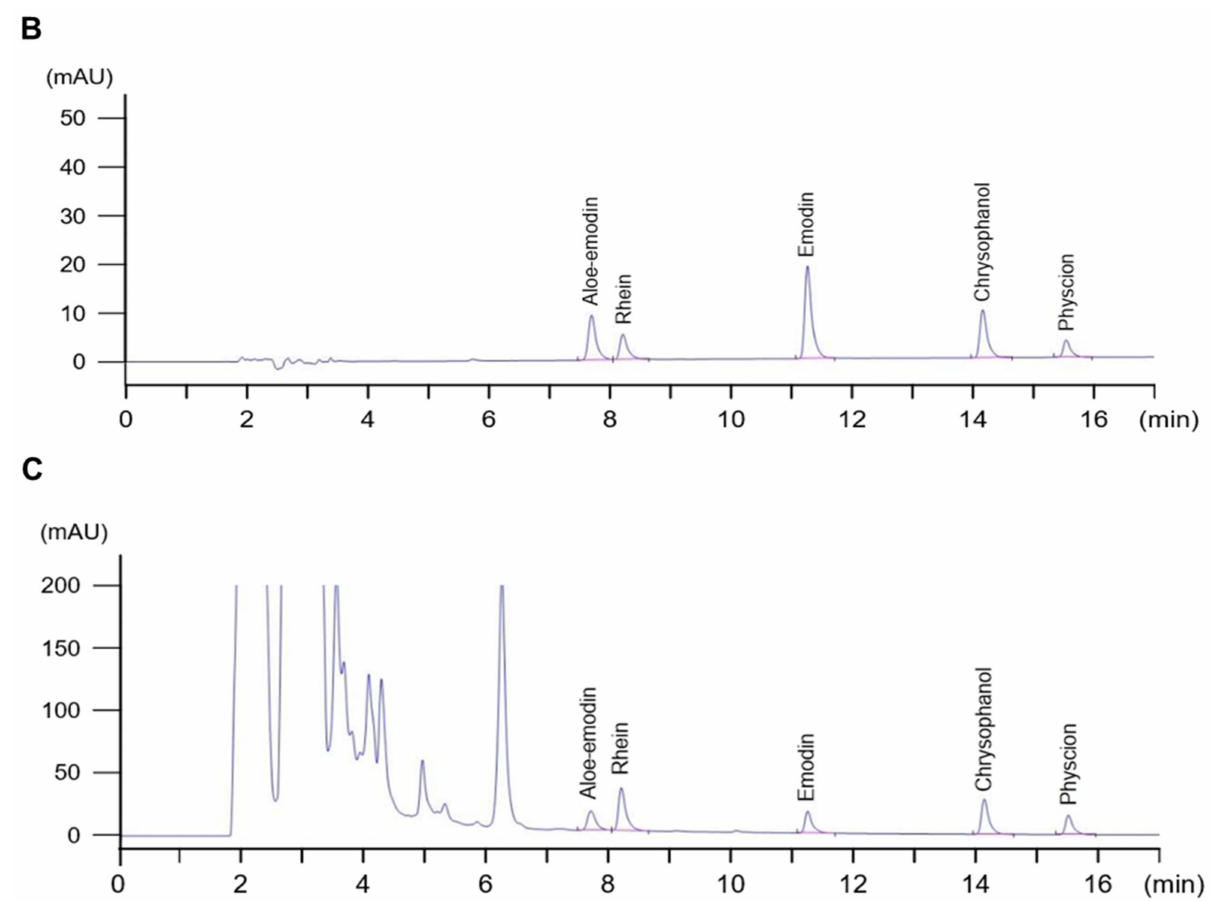
Figure 3. Primary constituents of RPE as determined by HPLC. ( A ) Chemical composition of RPE. ( B ) Chromatograms of the standard compounds ( B ) and RPE ( C